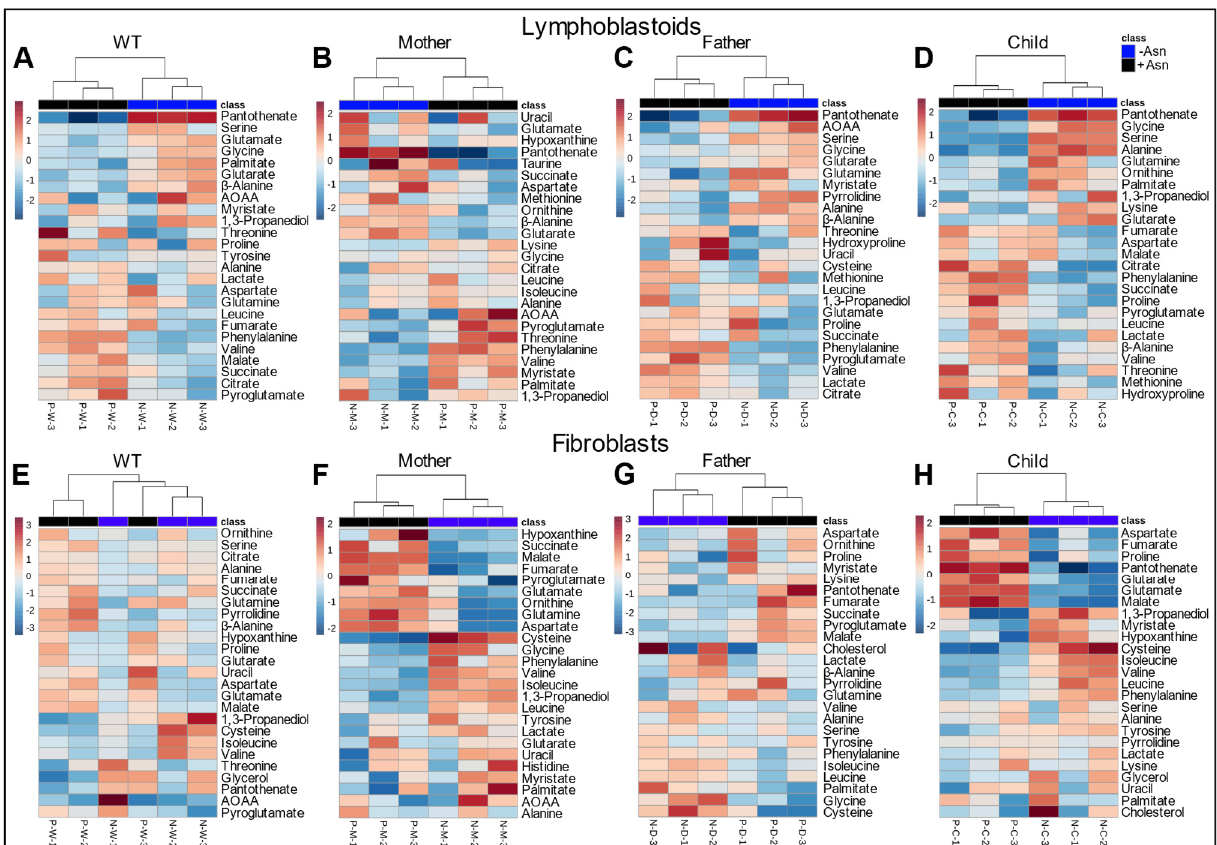
Figure 4. Hierarchical clustering between +Asn and − Asn LCL ( A – D ) and fibroblasts ( E – H ). Heatmaps discern di ff erential metabolite levels across the top 25 metabolites determined by analysis between cells incubated in +Asn and − Asn medium. Statistical signi fi cance was identi fi ed by p ≤ 0.05.